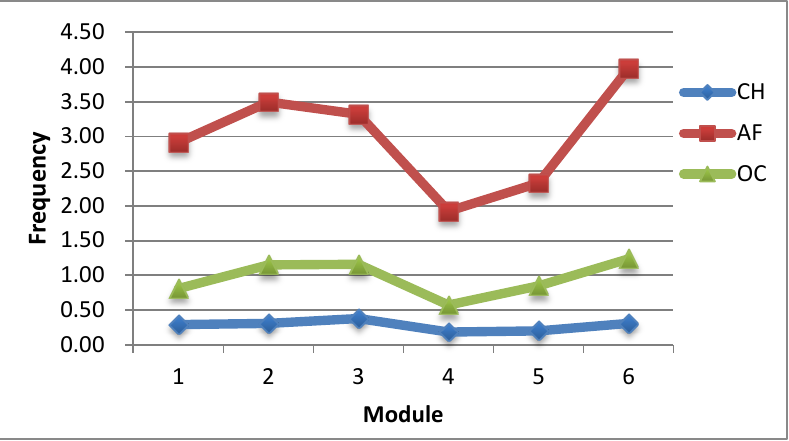
Figure 5. Average number and category of students’ social presence posts in each